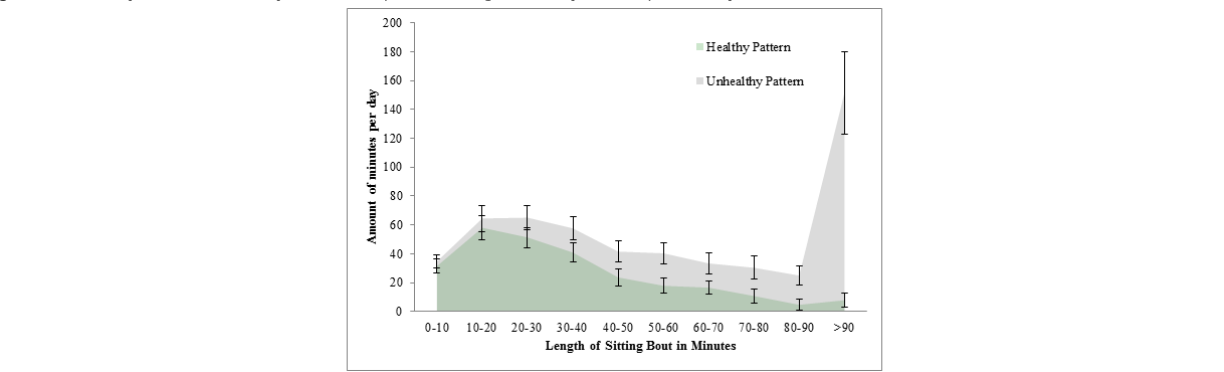
Figure 3. Healthy versus unhealthy summed squared sitting bouts days in the pilot